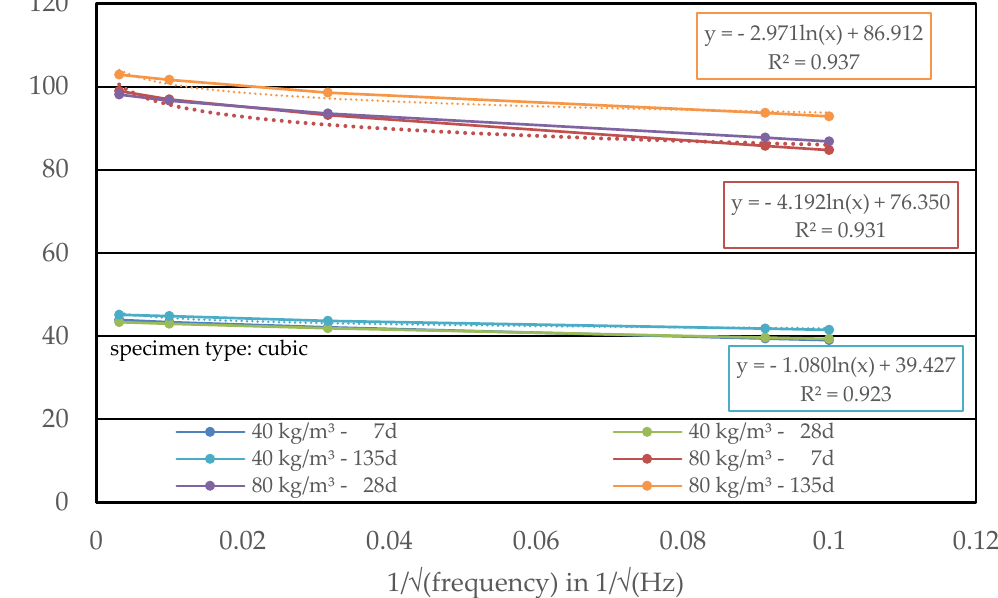
Figure 7. Calculated fibre content of the cubic specimens at varying frequencies of the alternating current of the samples with a fibre content of 80 kg/m³(dotted lines represent the fitted trend lines according to the equations given in the corresponding graph).